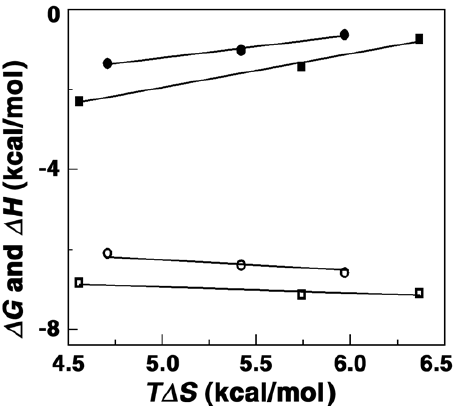
Figure 8. Plot of variation of thermodynamic parameters. D G ( # , N , & ) verses T D S for the binding of ADG and DAU to % ) and D H (